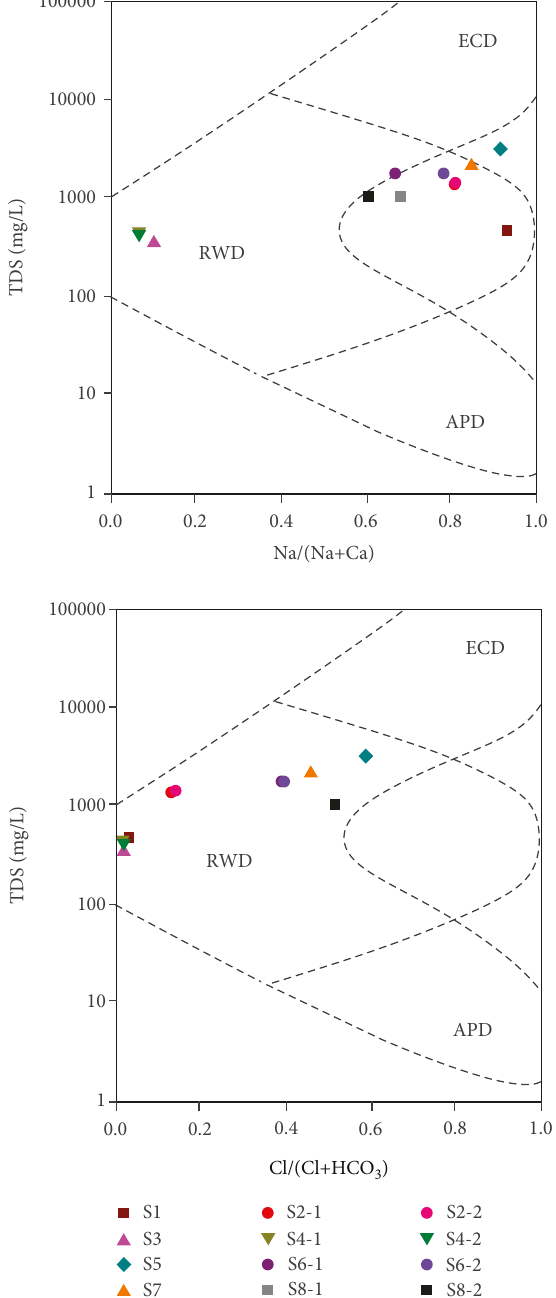
Figure 5: Gibbs diagram showing the hot spring water samples in the Simao